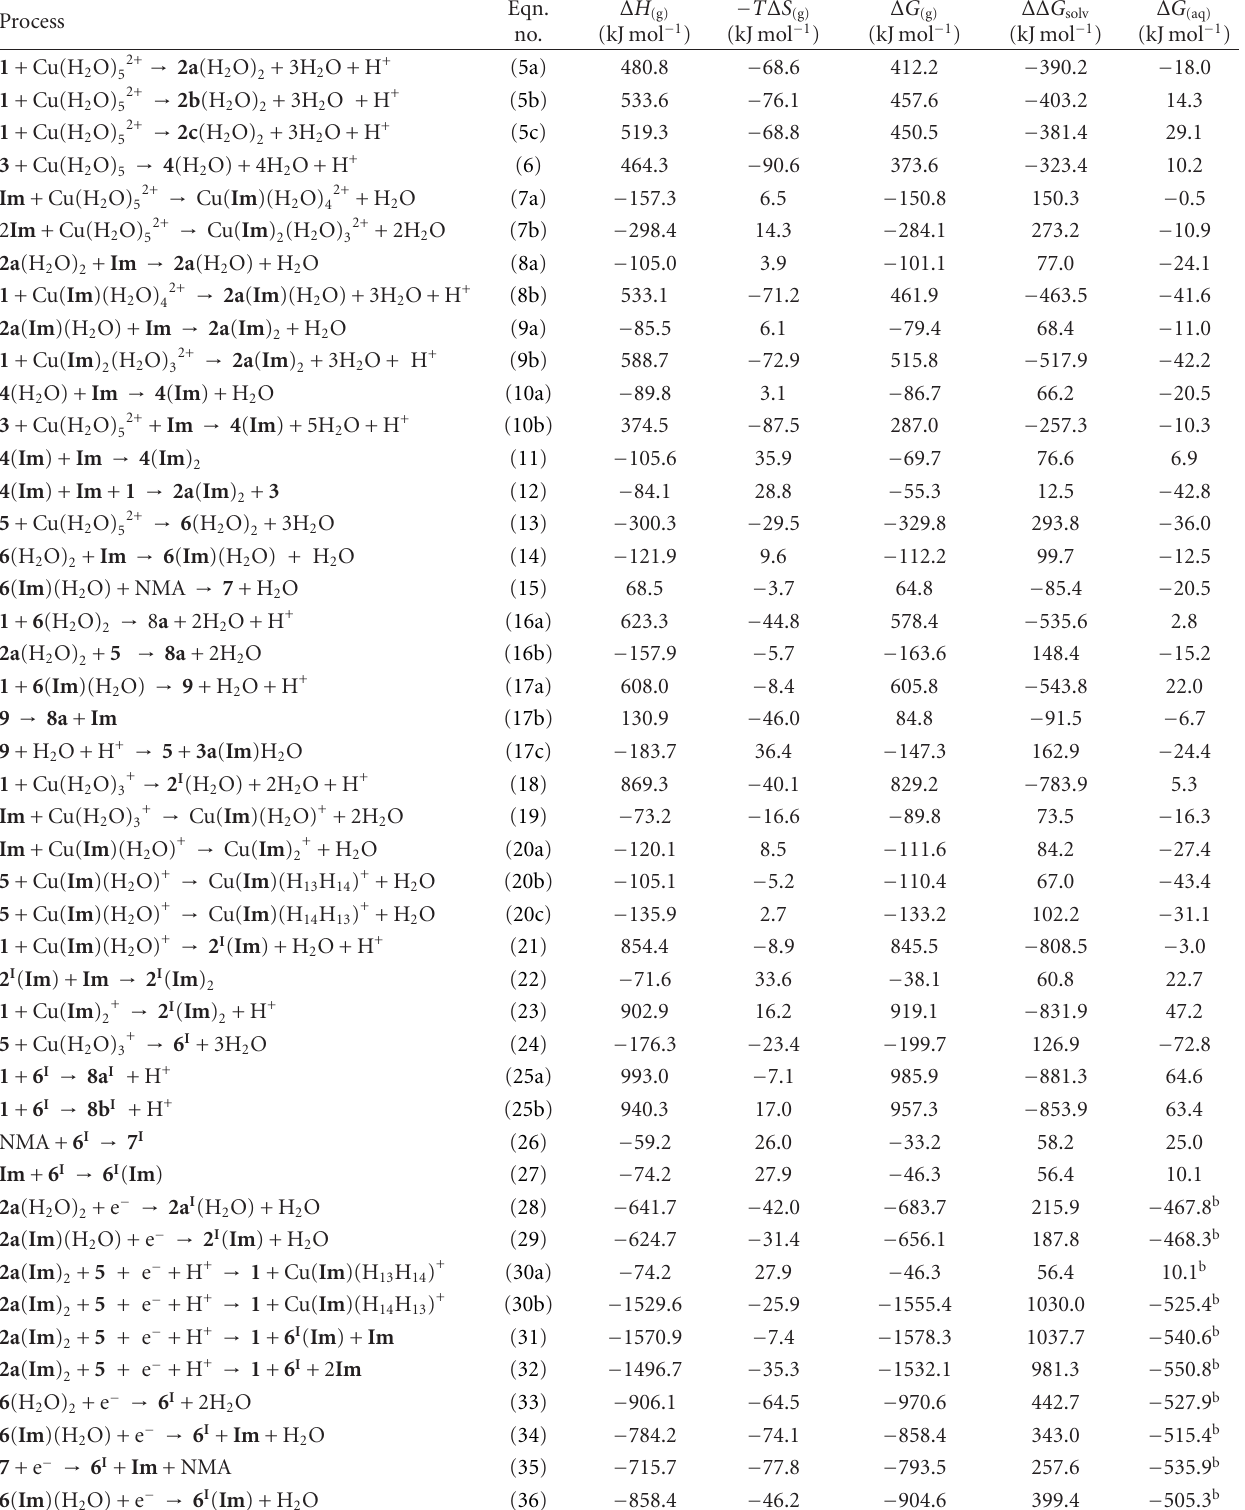
Table 1: Relative energies at 298K of species discussed in the text: enthalpies based on MP2/LB energies a .